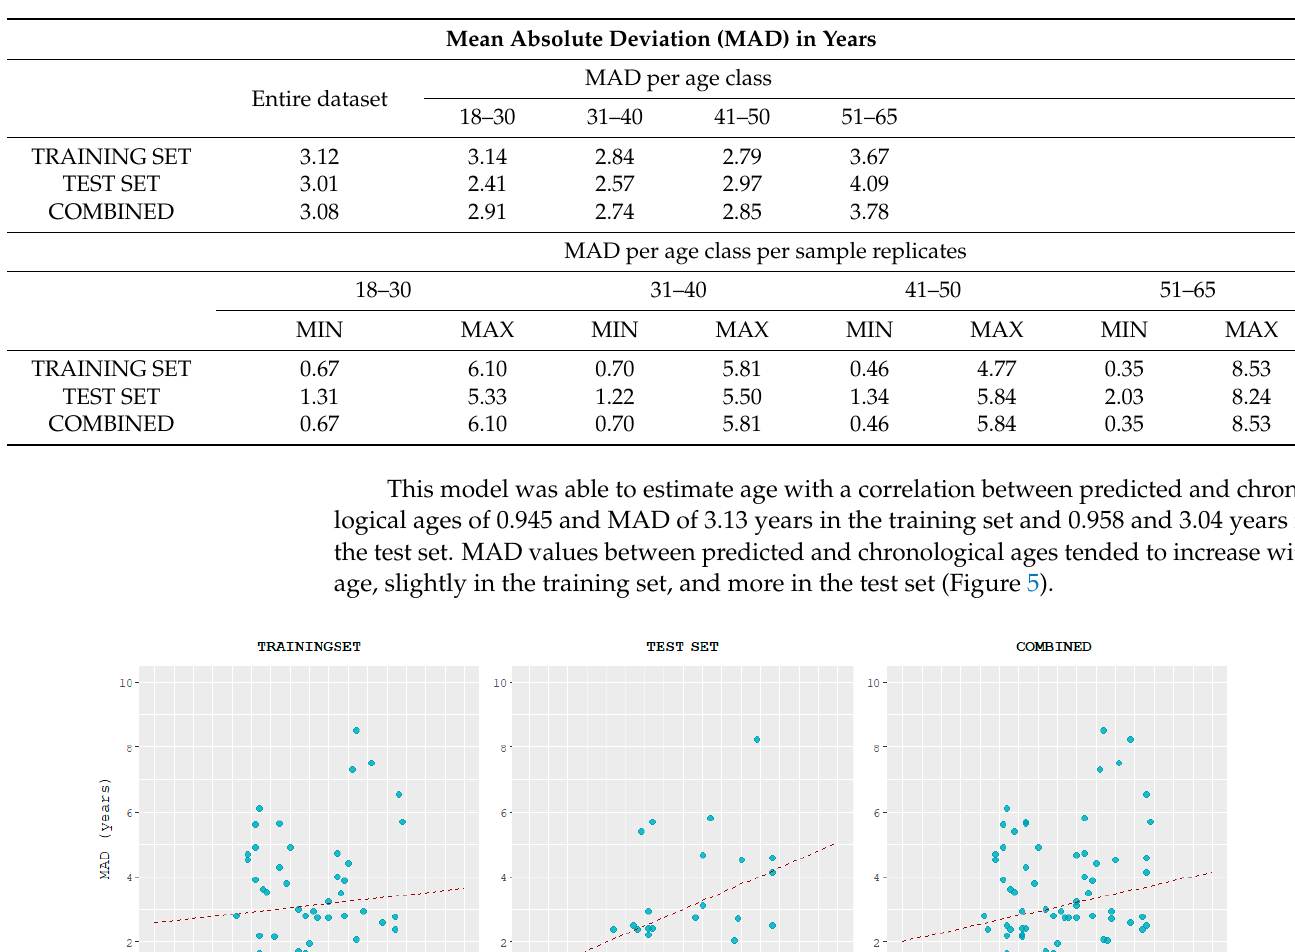
Table 2. Mean Absolute Deviation (years) values calculated for both datasets separately in their entirety and after dividing the samples into age classes (top rows). MAD was also calculated considering the sample replicates as a group and according to their age class (bottom rows). The same analysis was applied to the combined data set.